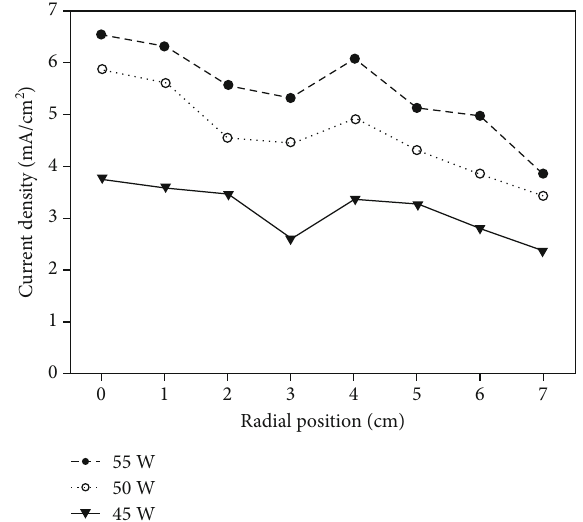
Figure 8: Current density distribution in radial position for various RF